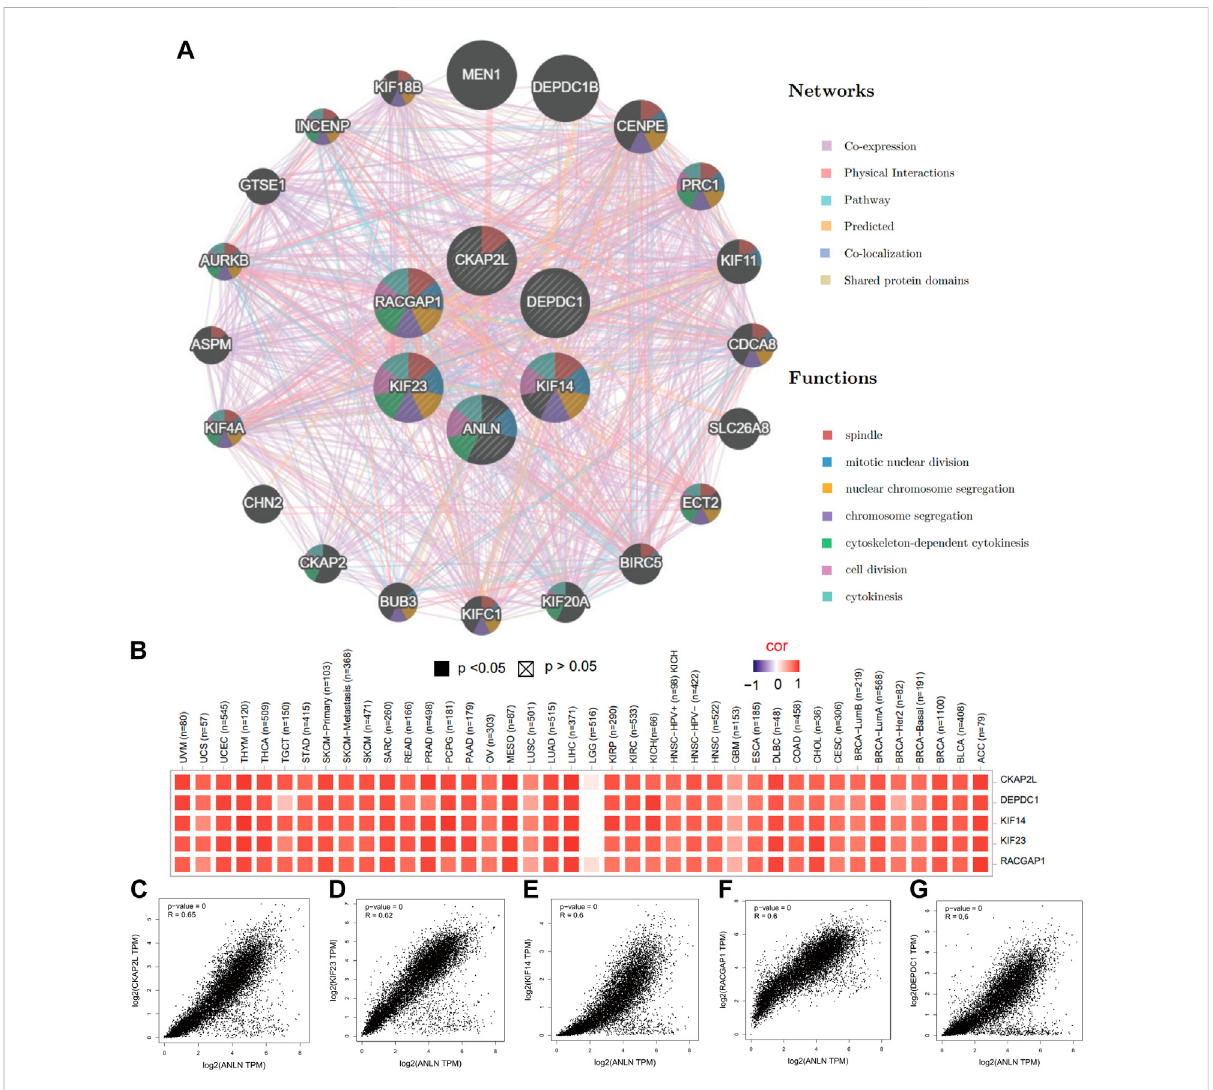
FIGURE 6 The top fi ve ANLN co-expressed genes in pan-cancer. (A) A protein-protein interaction network of ANLN and co-expressed genes using GeneMANIA. Different color represents different networks and functions. (B) Heatmap of relations between ANLN and the top fi ve genes in diverse TCGA tumors. Scatterplots showing the correlation between ANLN and CKAP2L (C) , KIF23 (D) , KIF14 (E) , RACGAP1 (F) , and DEPDC1 (G) in pan-